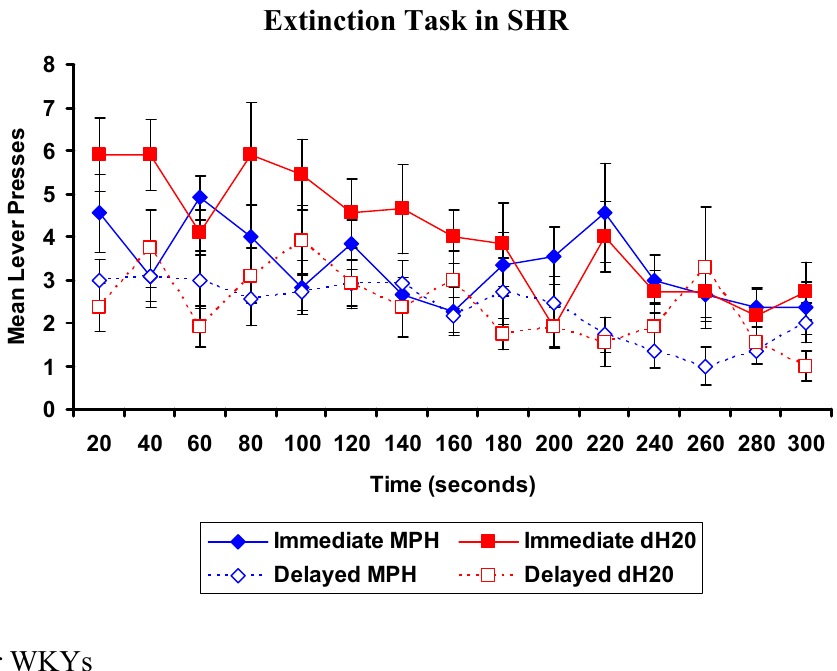
Figure 7. SHR: Mean (±SEM) number of presses on the immediate (closed) and delayed (open) levers in consecutive 20 s intervals for rats previously exposed to 4 weeks of oral methylphenidate (MPH, 2 × 2 mg/kg/day; blue diamond; n = 11) or distilled water (dH red squares; n = 11), during the extinction task. The extinction task was conducted 48 h following the final delayed reinforcement tasks (DRT)